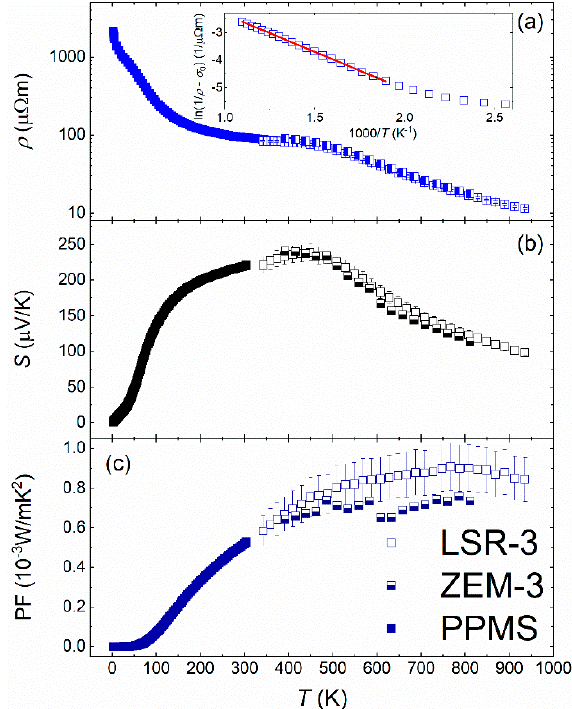
Figure 3. Temperature dependencies of ( a ) electrical resistivity (note semi-logarithmic scale), ( b ) Seebeck coefficient, and ( c ) thermoelectric power factor of ScNiSb. The inset in panel ( a ) shows the high-temperature ln(1 / ρ − σ 0 ) data vs. 1000 / T fitted with the Arrhenius model. Open, half-filled, and filled symbols represent the data collected using LSR-3, ZEM-3, and PPMS device, respectively.